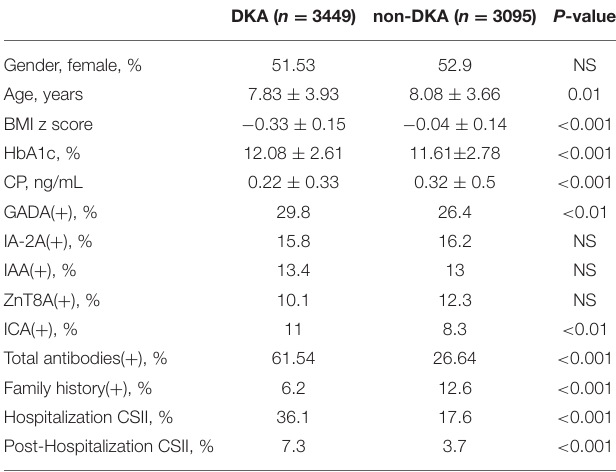
TABLE 2 | Participant clinical parameters comparing < 5 years, 5 to < 10 years and ≥ 10 years.